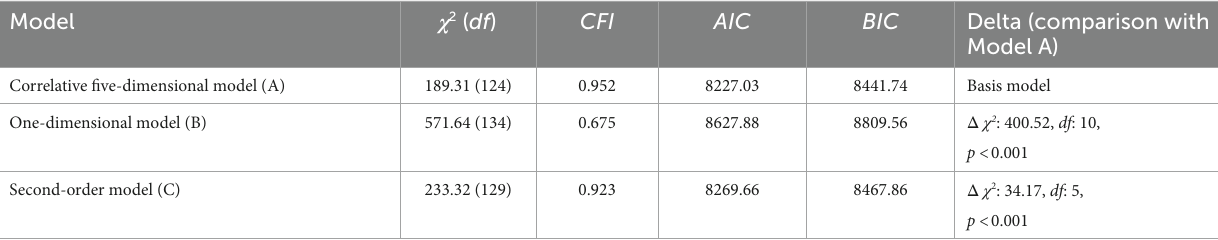
TABLE 3 Model comparison with optimized model: Results of χ 2 difference tests (corrected according to Santorra-Bentler).